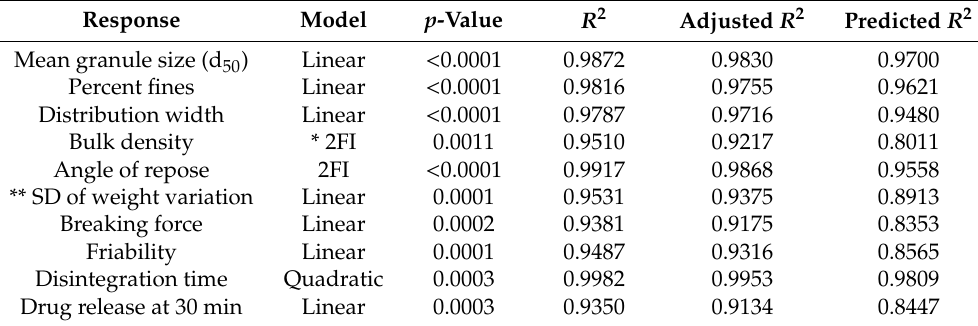
Table 1. Model summary statistics of dependent